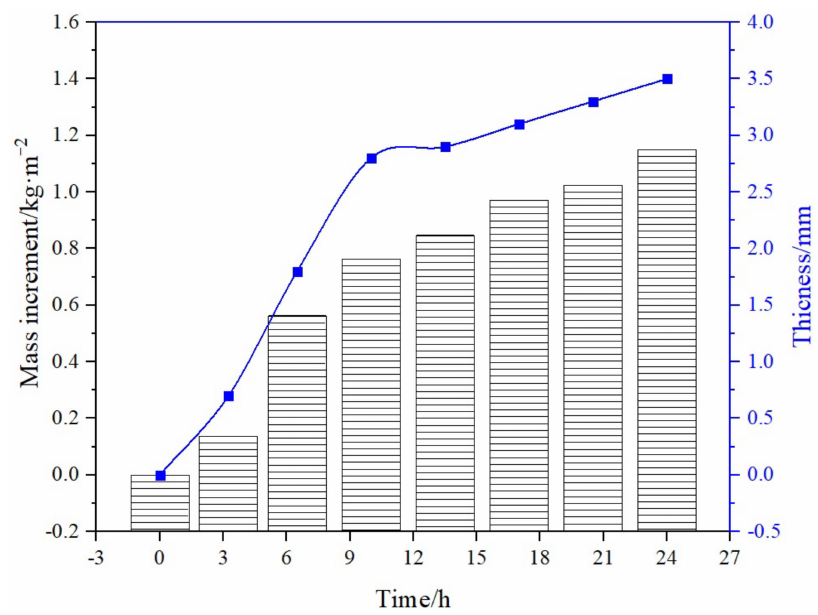
Figure 5. Mass increment and resin film thickness.